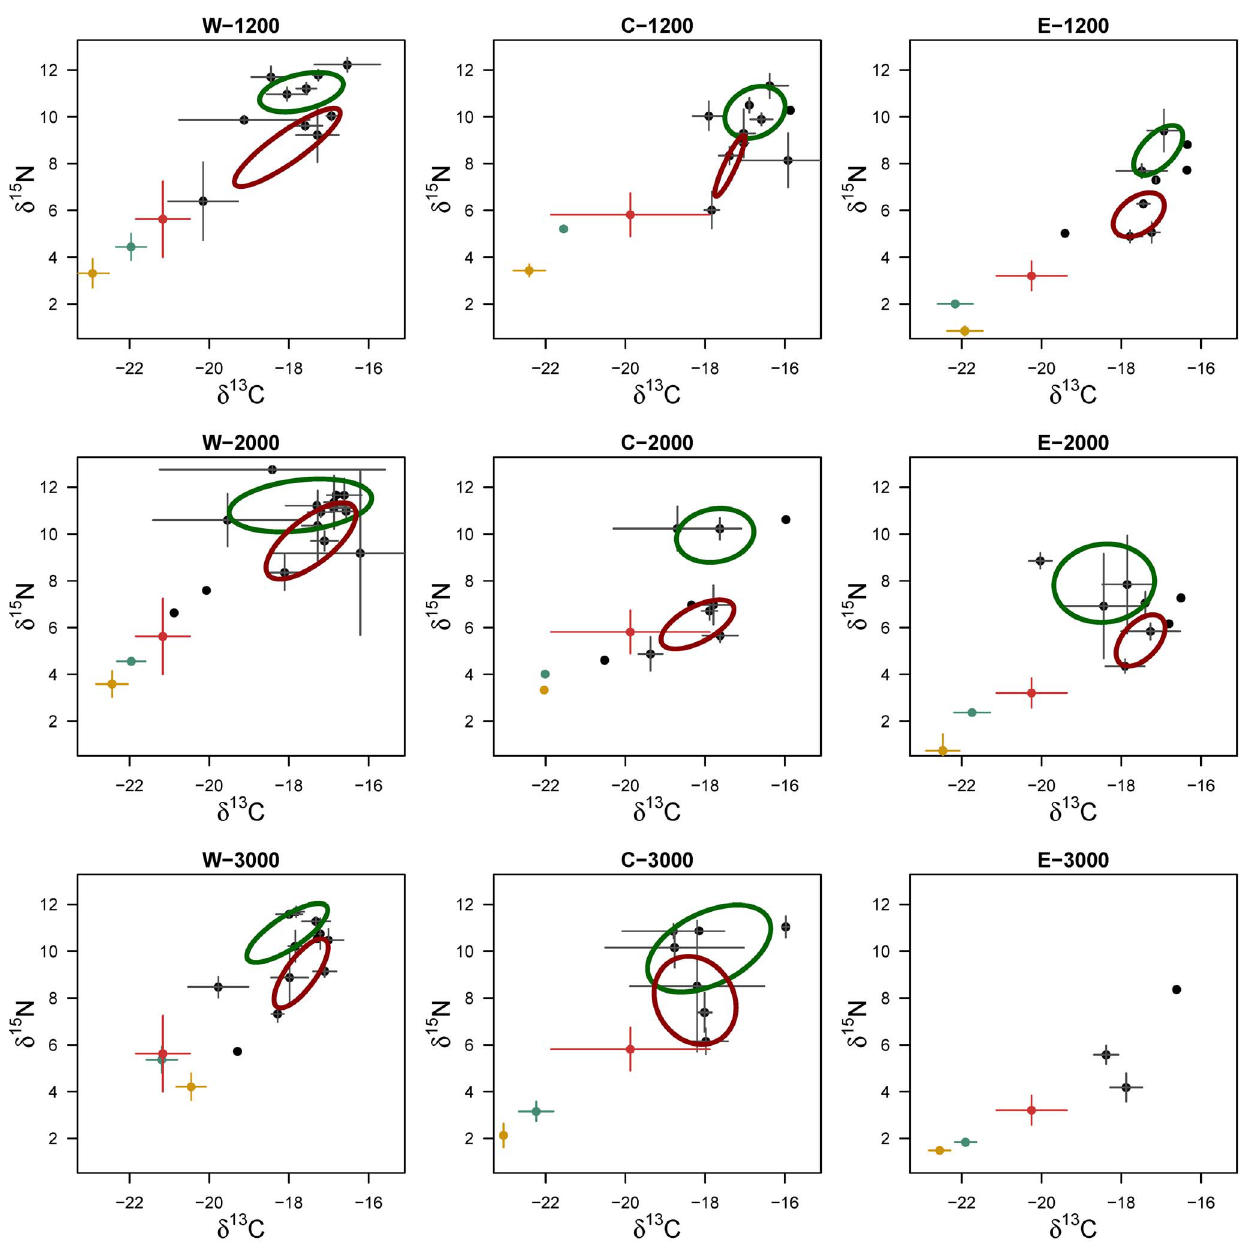
Figure 2. Isotopic biplots for the deep Mediterranean Sea. Mean d 13 C and d 15 N values for megafauna and plankton components in the 3 basins of the Mediterranean Sea at 3 different depths. Isotopic ellipses for each site are drawn separately for fishes (green) and crustaceans (brown) of benthic megafauna. Colour codes for points: yellow – microplankton, red – mesozooplankton, green – mesopelagic macroplankton, grey – demersal megafauna.